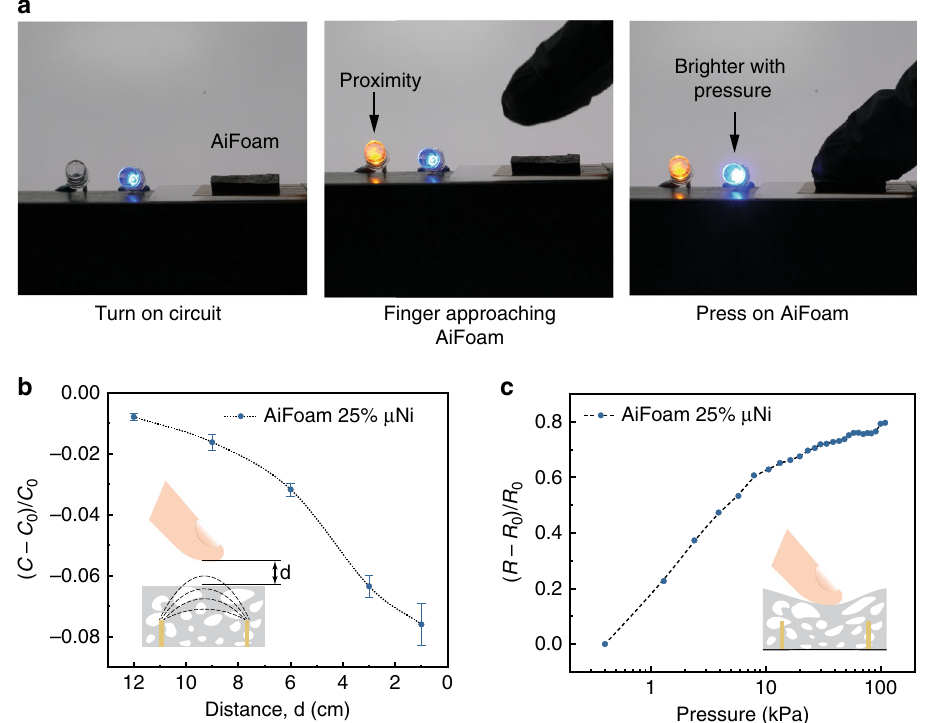
Fig. 6 Capacitive proximity sensing and resistive pressure sensing. a Photographs showing both proximity sensing and pressure sensing of AiFoam sensor. Left The blue LED is activated, indicating the electrical circuit is turned on. Middle The orange LED lighted up when the human fi nger approaches to the sensor. Right The blue LED becomes brighter when the fi nger touches and presses the sensor. b The capacitance change responses on the distance between the fi nger and the AiFoam sensor (with 25 vol% μ Ni). The error bars are calculated based on three tests. C 0 represents the initial capacitance of the sensor and C represents the capacitance of the sensor during the proximity test. d represents the distance between the human fi nger and AiFoam. c The resistance change responses on external pressure of AiFoam sensor (with 25 vol% μ Ni). R 0 represents the initial resistance of the sensor and R represents the resistance of the sensor during the pressure